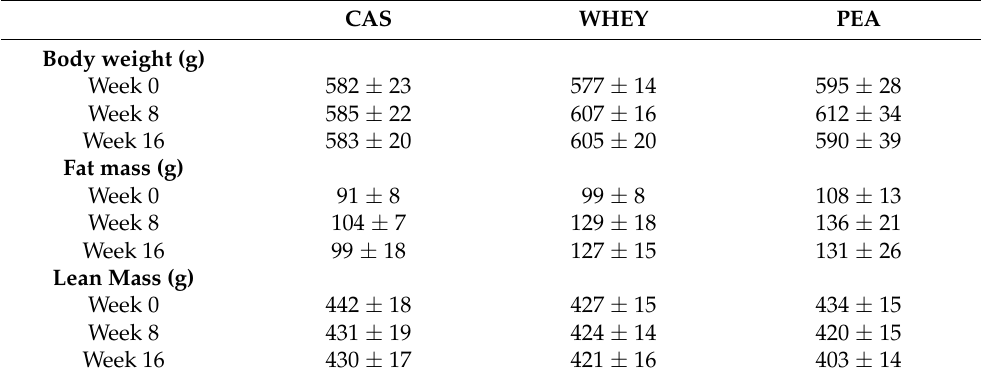
Table 4. Body weight, fat mass and lean mass variations over the course of the experimental study.